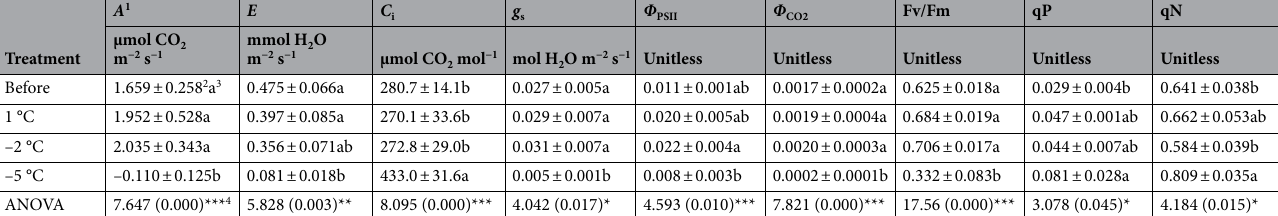
curves (i.e., A - PPFD curve) presented an apparent down-regulated photosynthetic capacity in the seedlings treated with − 5 °C under saturating light conditions. Over all the PPFD measured, A remained negative, indi- cating the leaves were damaged after the − 5 °C treatment were respiring at all light levels. However, similarly to the A – C i responses, the 1 and − 2 °C treatments both did not produce a significant reduction in A , although these are damaging low temperatures in avocado demonstrated in the literature 3 . This is likely because the plants used in our study were adapted to low temperatures for a few months even before treatment (average growing temperature of 10.53 °C and 11.06 °C for the two months prior to the experiment). Under the ambient growing conditions at 400 µmol CO 2 m −2 s −1 with saturating light intensity of 1500 PPFD , the avocado leaves in the seedlings treated with − 5 °C showed lower gas exchange and chlorophyll fluorescence values in A , E , g s , Φ PSII , Φ CO2 , and Fv/Fm and higher values in C i , qP, and qN in comparison with the leaves in the seedlings before treatment and treated with 1 and − 2 °C (Table 2). The changes in these values indicate not only reduced photosynthetic CO 2 assimilation and transpirational H 2 O release but also increased photoprotec- tion operating to compensate for the decreased utilization of absorbed light energy harvested in PSII by chilling stress from low temperature. A notable decrease in g s of the leaves in the seedlings treated with − 5 °C confirms the stomatal limitation of photosynthetic CO 2 uptake. The subsequent negative A value along with increased C i in the leaves in the seedlings treated with − 5 °C implies the damaged tissues by chilling stress only afforded res- piration, not photosynthesis. Also, the non-stomatal limitation was observed in the following manner. Increased qP in the leaves in the seedlings treated with − 5 °C could be likely from increased photochemical quenching of absorbed light energy through photorespiration, not through photosynthesis. Such down-regulation, in turn, appeared to induce non-photochemical quenching of the excess energy, increased qN in the leaves in the seed- lings treated with − 5 °C. These photosynthetic alterations were reported in the literature as adaptive responses to low temperature 47,48 . Overall, from the response curve analysis, it was observed that the exposure to short-term low temperature led to stomatal and non-stomatal limitation of photosynthesis in avocado leaves, which only occurred at the leaves in the seedlings treated with − 5 °C, not at 1 and − 2 °C. In response to the downregulation of photosynthesis, the photoprotection in the leaves in the seedlings treated with − 5 °C was induced; nevertheless, the damaged PSII could not withstand saturating light intensity.